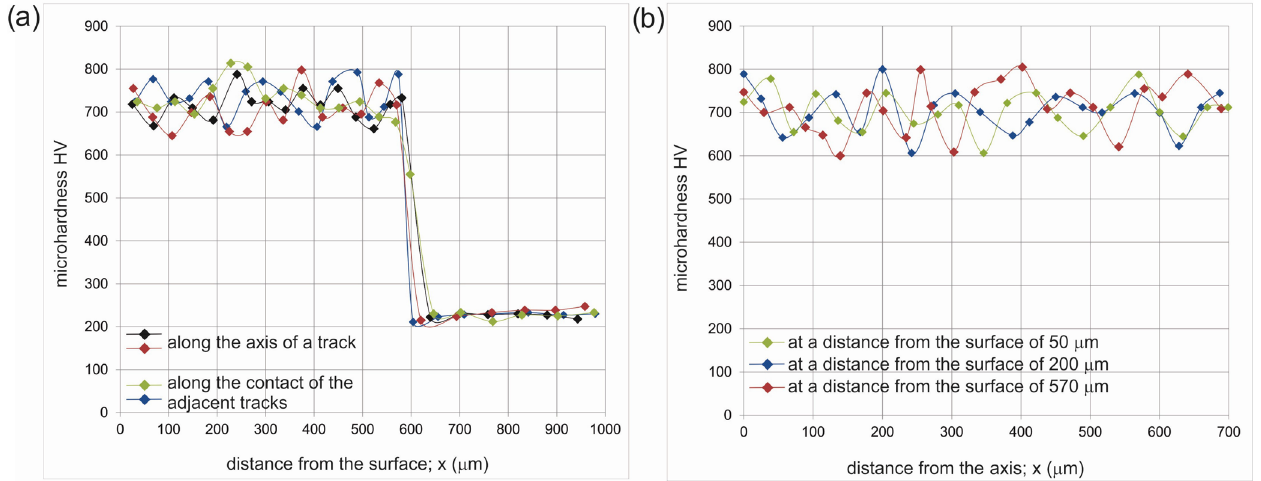
Figure 14. The microhardness profiles of laser borided layer produced on Nimonic 80A alloy at the laser beam power of 1.95 kW: ( a ) measurements along the axis of a track and along the contact of the adjacent tracks; ( b ) measurements along the straight line parallel to the surface.